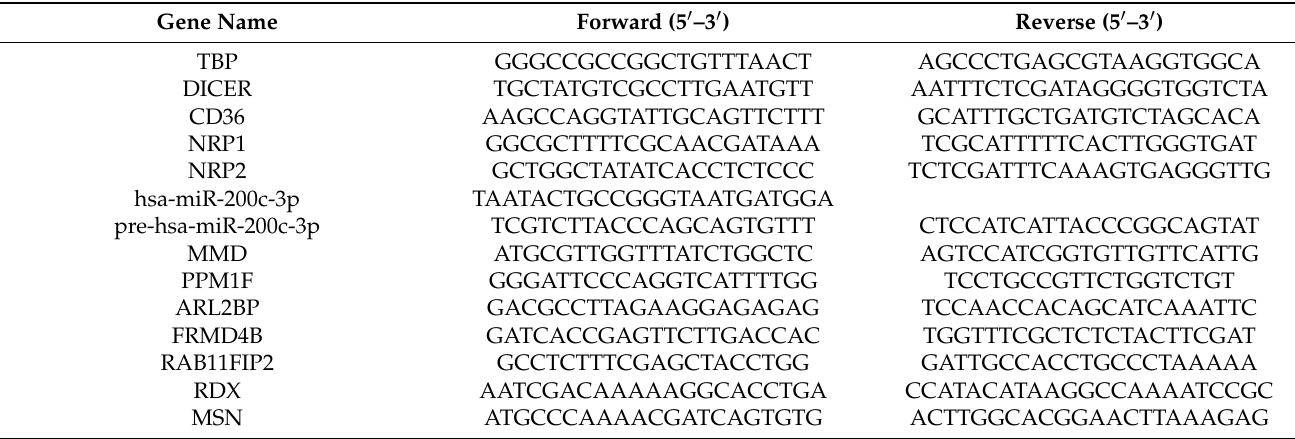
Table 1. Human primers used for qPCR